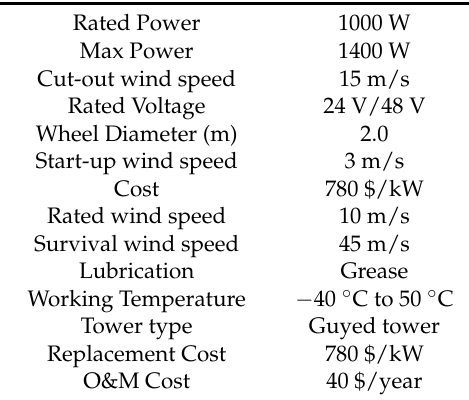
Table 2. Wind turbine specifications used for